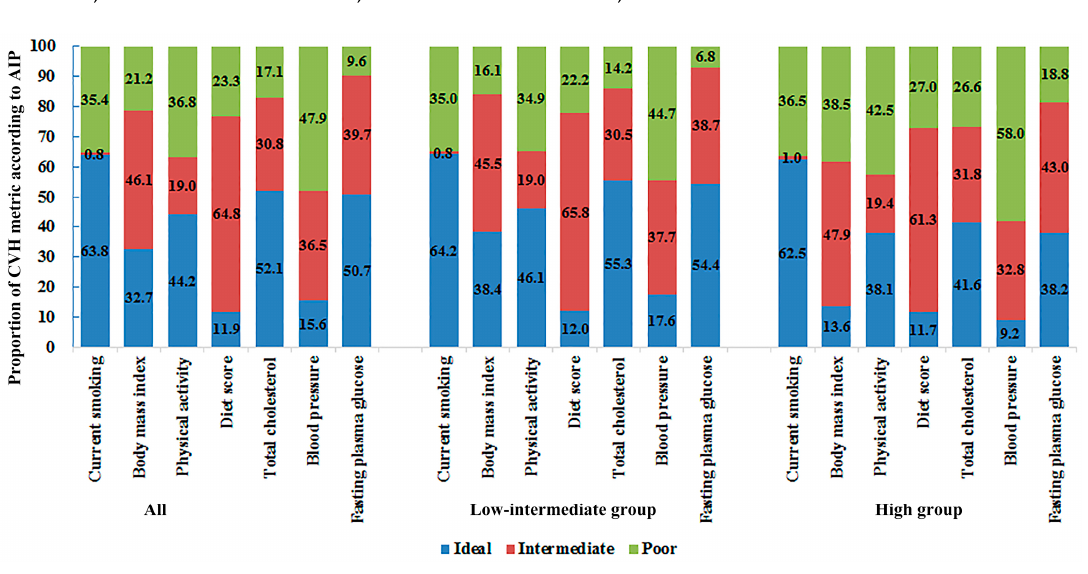
Figure 1. The distribution of CVH metrics according to AIP (low-intermediate vs. high). AIP, atherogenic index of plasma; CVH, cardiovascular health.